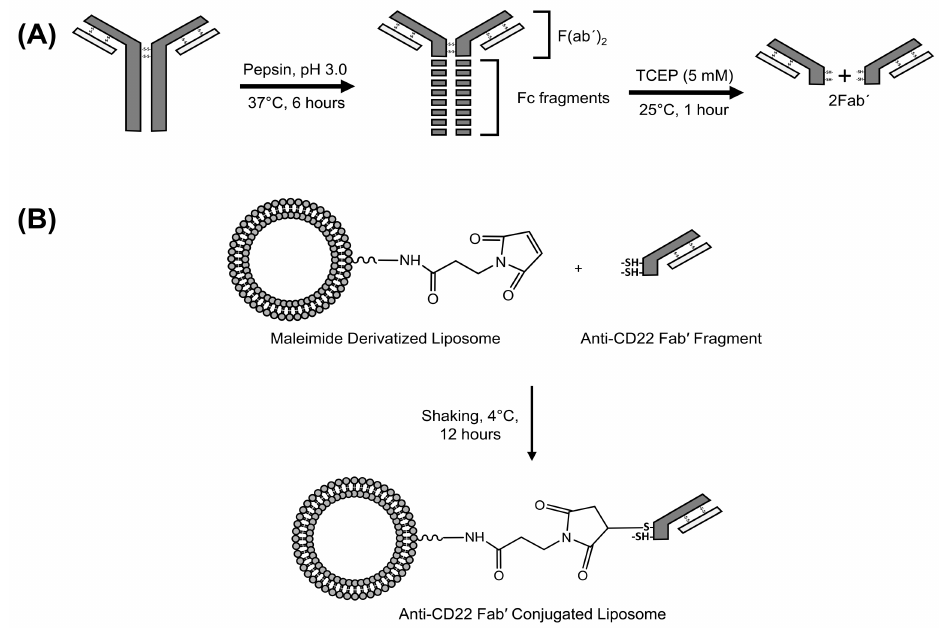
Figure 2. ( A ) Schematic for generation of anti-CD22 Fab’ fragments; and ( B ) Conjugation of anti-CD22 Fab’ to maleimide derivatized LCLA (untargeted long circulating liposomal AD